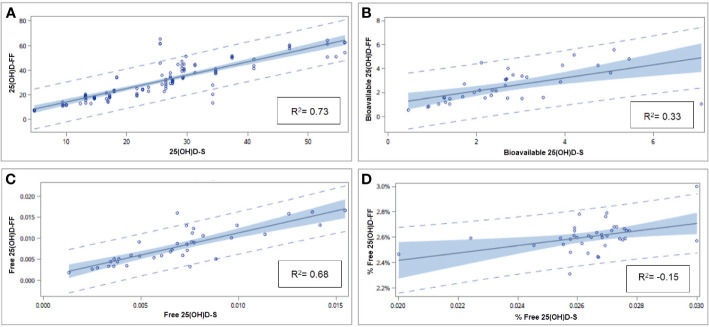
Linear regression between 25(OH)D (A), bioavailable 25(OH)D (B), free 25(OH)D (C), and % free 25(OH)D (D) in S and FF. Linear regression model is presented with p values and coefficient of determination (R2). S, serum; F, follicular fluid.